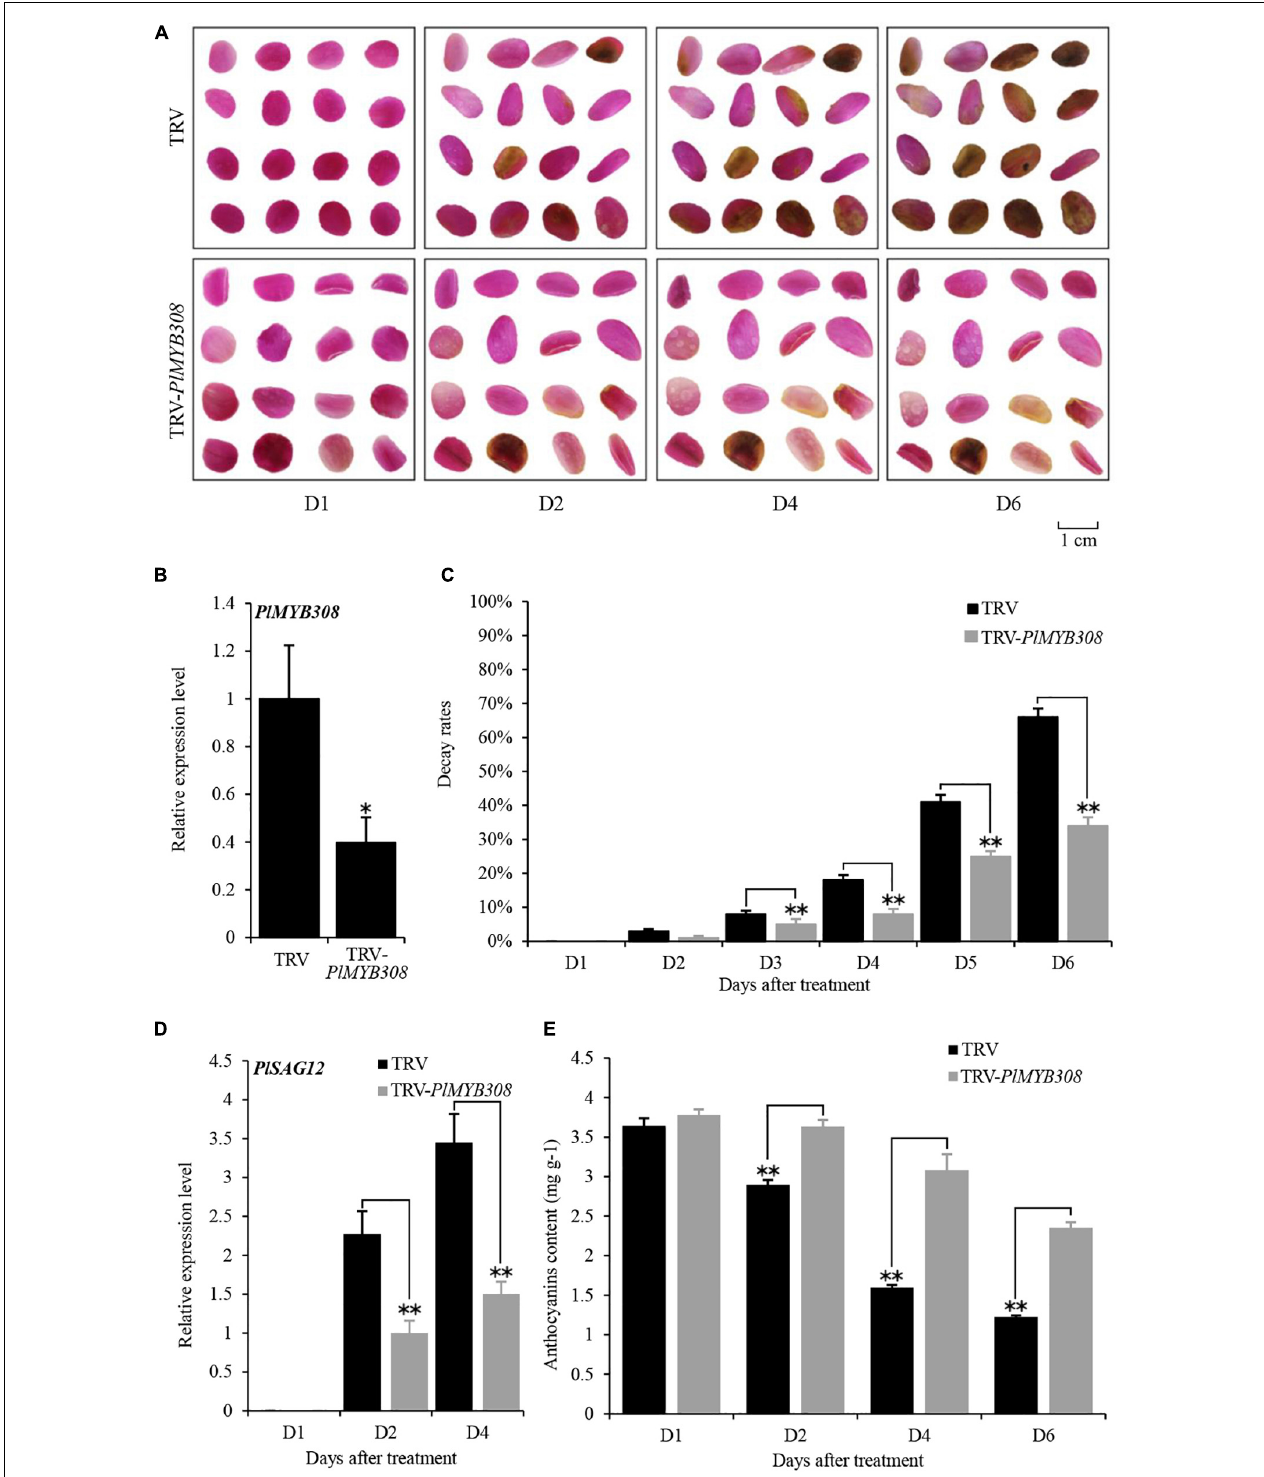
FIGURE 2 | PlMYB308 silencing delayed senescence of herbaceous peony petal disks. (A) The phenotypes of the petal disks were photographed at D1, D2, D4, D6 after infiltration with TRV empty vector and TRV- PlMYB308 . (B) Abundances of PlMYB308 transcript in empty vector- and TRV- PlMYB308 -infected petal disks at D4. PlUB was used as an internal control. (C) Decay rates of the petal disks infiltrated with TRV empty vector and TRV- PlMYB308 . Means ± SD for 300 petal disks. (D) Expression levels of PlSAG12 by quantitative real-time PCR in empty vector- and TRV- PlMYB308 -infiltrated petal disks. (E) The anthocyanin content at D1, D2, D4, D6 after infiltration with TRV empty vector and TRV- PlMYB308 . Error bars showed SD of the means of three biological replicates. Asterisks indicated statistically significant differences by Student’s t -test (* P < 0.05, ** P < 0.01).